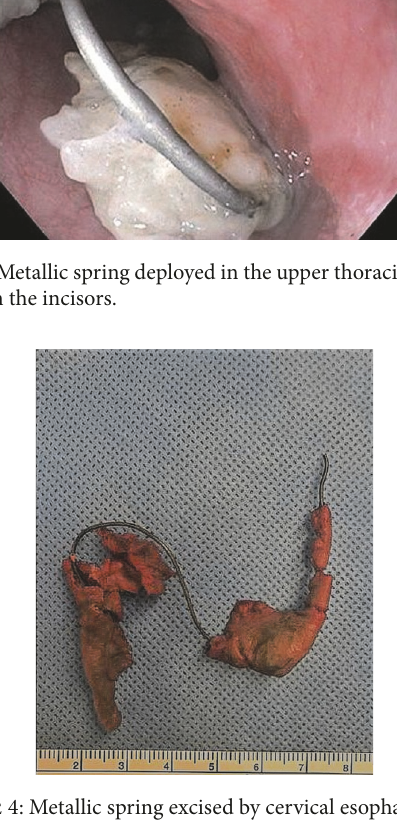
Figure 4: Metallic spring excised by cervical